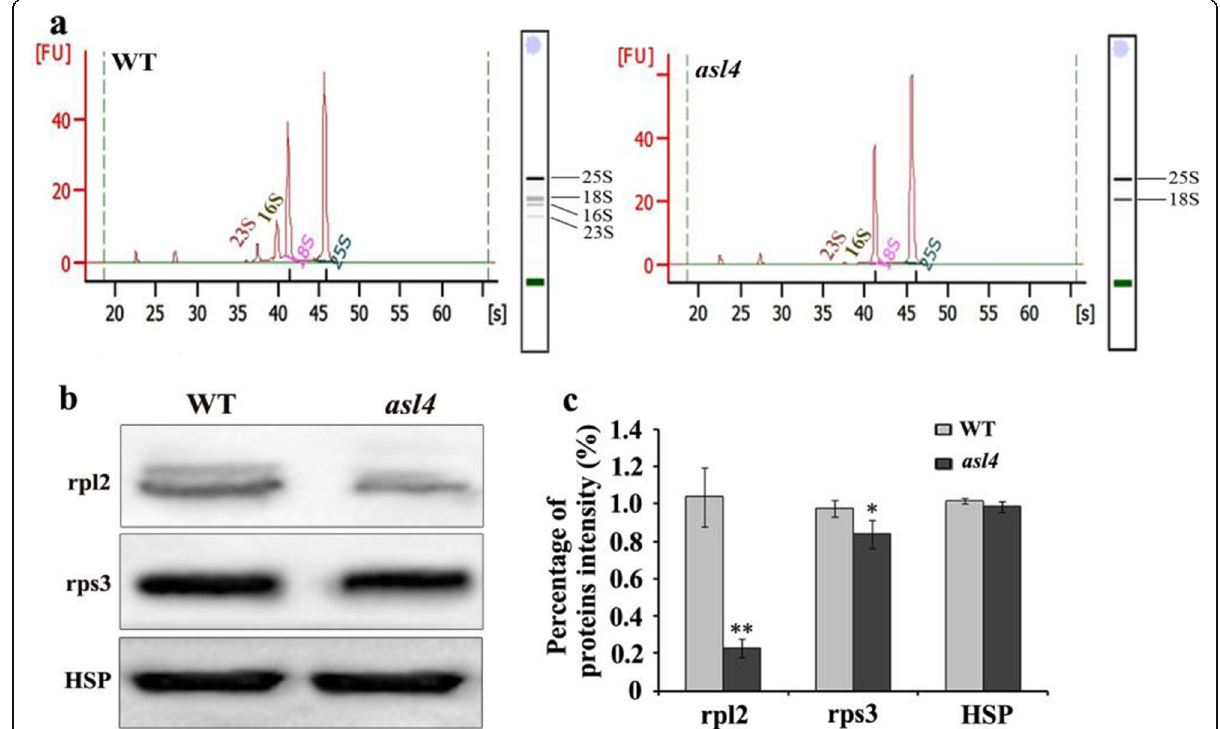
Fig. 9 Plastid rRNA and ribosomal protein levels in wild-type and asl4 mutant seedlings. a rRNA analysis of wild-type and asl4 mutant seedlings at the L3 stage using an Agilent 2100 analyzer. b Western blot analysis of plastid ribosomal proteins in wild-type and asl4 mutant seedlings at the L3 stage. HSP 82 was used as internal control. c Quantification of the band intensity of plastid ribosomal proteins corresponding to b . Data are means ± SD of three independent repeats. ** and *, indicate significance at P = 0.01 and P = 0.05, respectively, by Student ’ s t